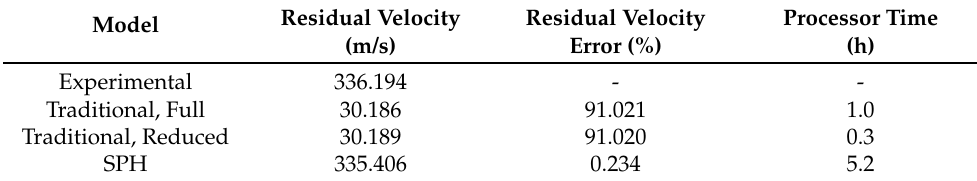
Table 3. Comparison of Computational